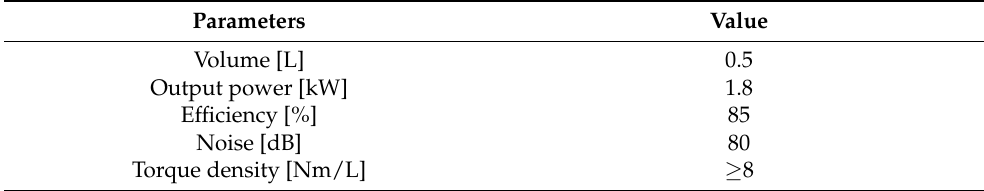
Table 1. Specification of 12/8 switched reluctance motor (SRM).